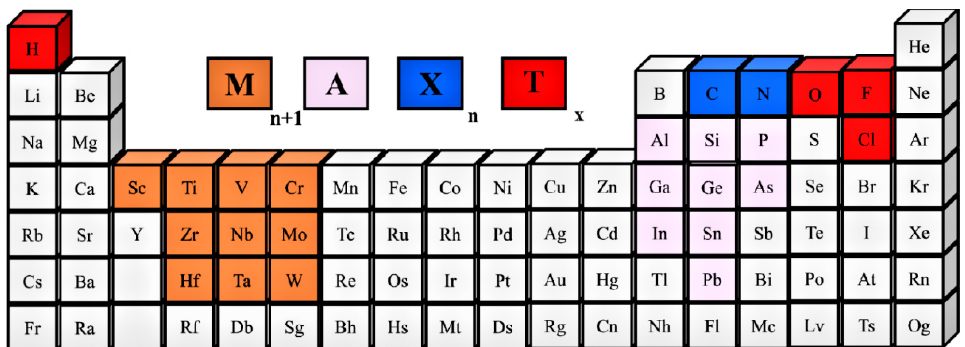
Figure 2. Periodic table showing MAX composition. Reprinted with permission from [52]. Copyright © 2021, American Chemical Society, CC-BY-NC-ND 4.0 license.